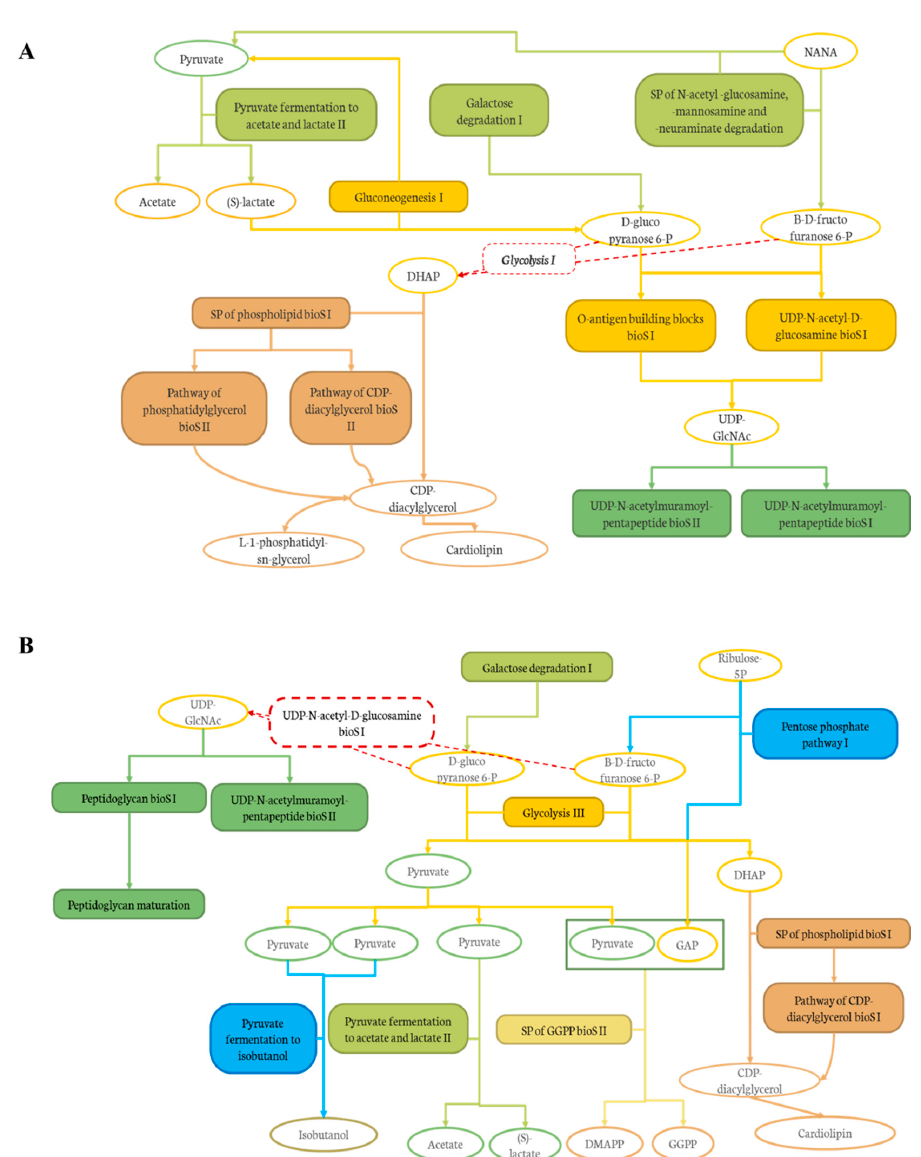
Figure 8. Graphical representation of the links between the pathways and SP induced by ( A ) the 60% DCJ and ( B ) the 80% DCJ in the gut microbiota of the treated mice in comparison with a 0% DCJ. Filled frames represent degradation (light green), sugar biosynthesis (dark yellow), pentapeptide biosynthesis (dark green), lipid biosynthesis (brown), generation of precursor metabolites and energy (blue), and polyprenyl biosynthesis (light yellow).